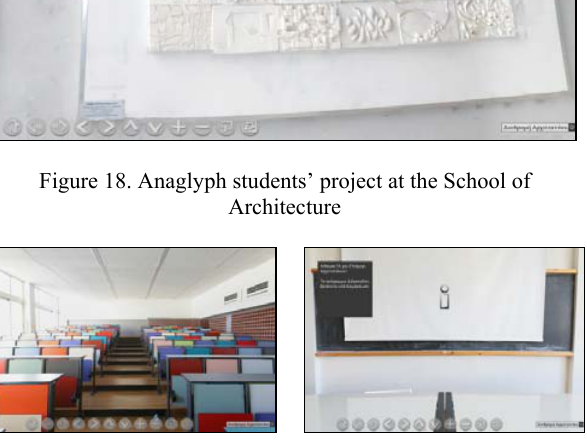
Figure 19. An amphitheater from the blackboard (left); the information symbol (i) provides access to the list of offered